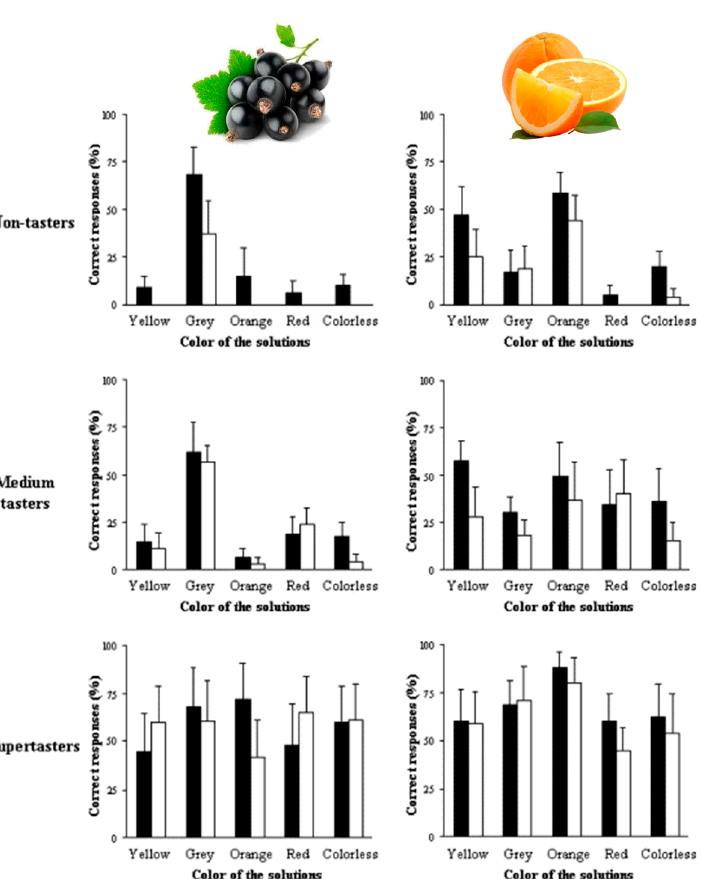
Figure 3. Mean percentage of correct flavor identification responses in blackcurrant and orange solutions, for the three groups of participants (non-tasters, medium tasters, and supertasters). Black columns are solutions where fruit acids had been added; white columns are solutions without fruit acids. Adapted from Zampini et al. [11].